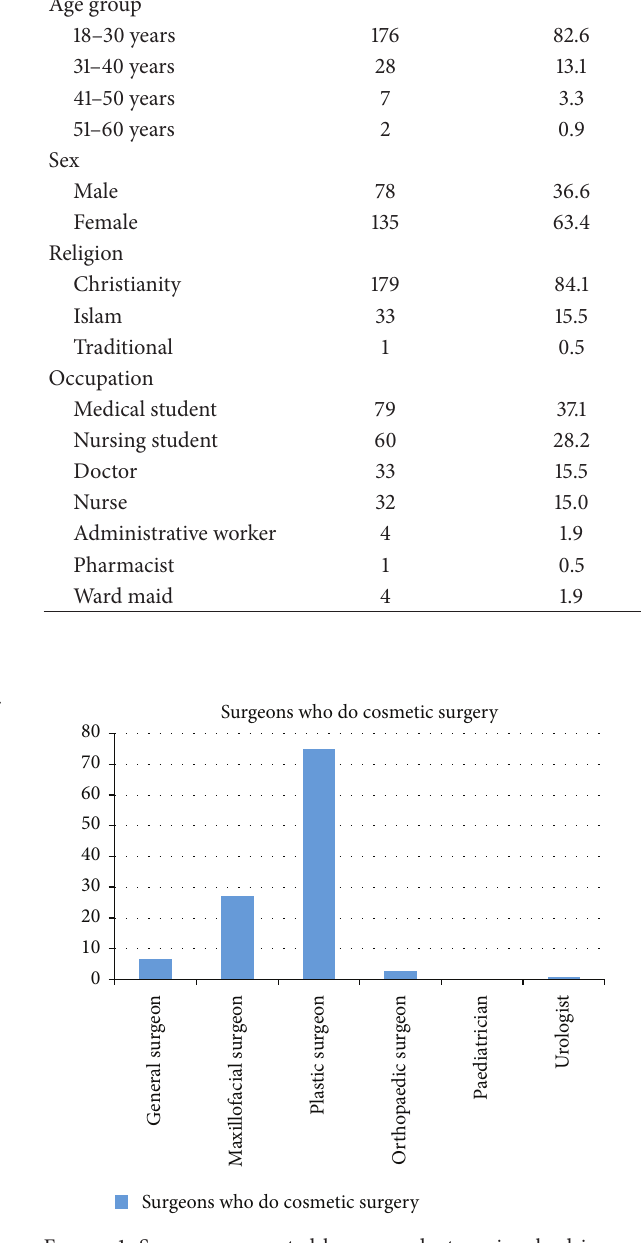
Figure 1: Surgeons suggested by respondents as involved in cos- metic